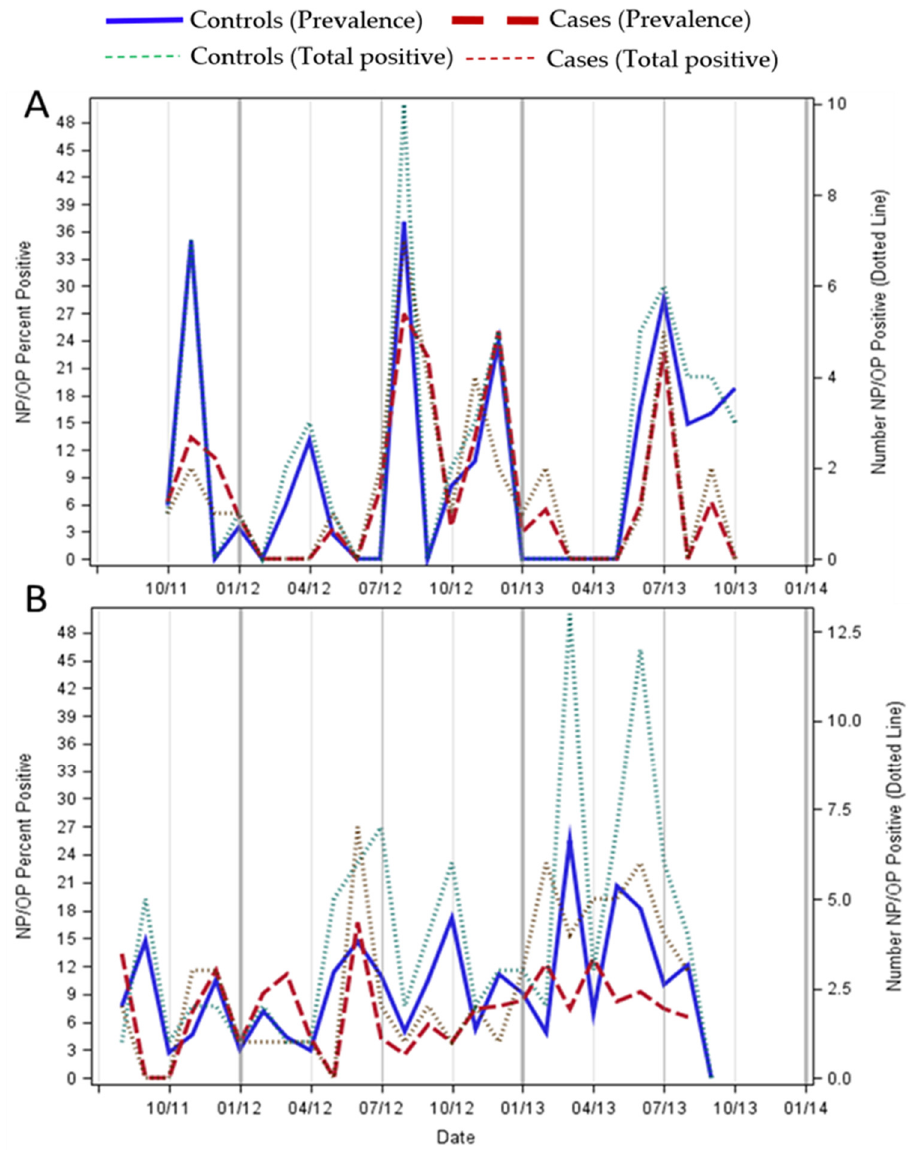
Figure 1. The seasonal distribution of HCoV over a period of two years in children hospitalized with pneumonia and asymptomatic controls in Zambia (Panel ( A )) and South Africa (Panel ( B )). Prevalence is the % of samples that tested positive for HCoV for each month for cases (dashed red line) and controls (solid blue line), with the actual number of HCoV positives for each month on the z axis for cases (dotted green line) and controls (dotted red line).